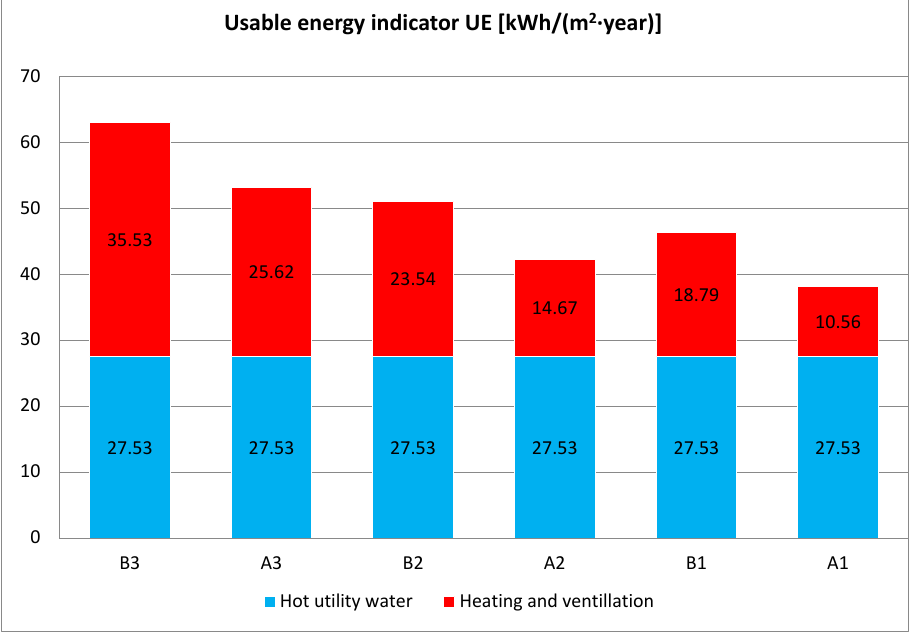
Scheme 1. Comparison of usable energy indicators for a building of a different energy class. Energies 2023 , 16 , x FOR PEER REVIEW